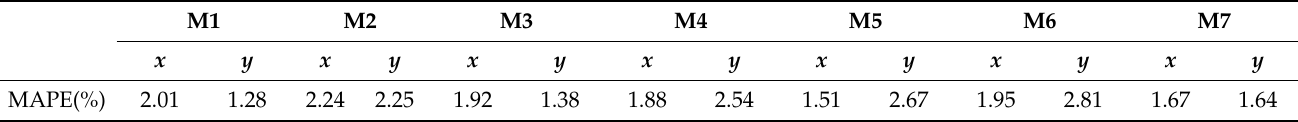
Table 16. Table 16. MAPE for all markers during prediction period t = 1, 2, . . . , 25. Table 16. MAPE for all markers during prediction period t = 1, 2, …, 25.